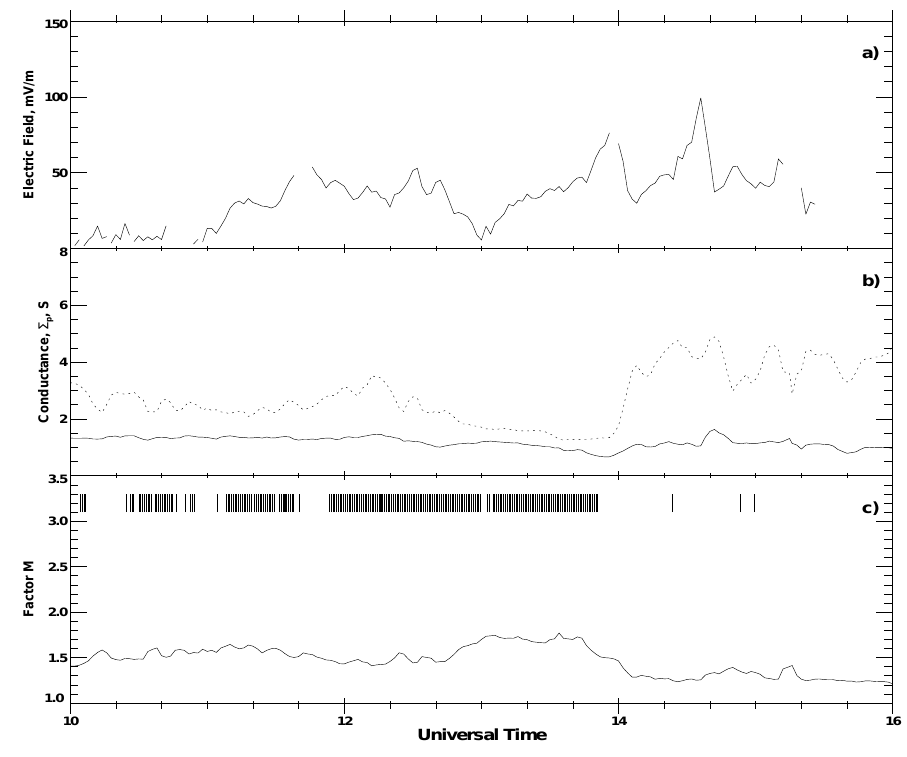
Fig. 10. The same as in Fig. 9, but for 12 February 1999 observations between 10:00 and